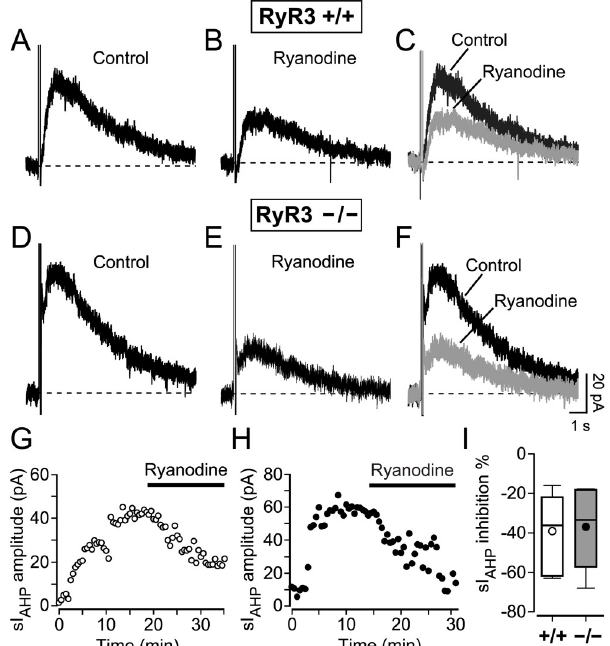
Fig 5. Inhibition of CICR by ryanodine reduced the sI AHP amplitude at steady state in RyR3 +/+ and RyR3 − / − mouse CA1 pyramidal neurons. Representative sI AHP traces obtained from RyR3 +/+ ( A ) and RyR3 − / − ( D ) mouse CA1 pyramidal neurons at steady-state, at the end of the run-up phase. Current traces from the same neurons 15 minutes after the application of 10 μ M ryanodine (RyR3 +/+ ( B ) and RyR3 − / − ( E )). ( C and F) Superimposed traces showing the reduction of the sI AHP amplitude. Scale bars in ( F ) apply to all panels, ( A-F ). ( G ) Time course of sI AHP amplitude in the same RyR3 +/+ neuron as shown in A-C. ( H ) Time course of the sI AHP amplitude in the same RyR3 − / − neuron as shown in D-F. ( I) Overall decrease in the sI AHP amplitude summarized in a box-and-whiskers plot, showing comparable reduction by ryanodine in RyR3 +/+ (mean ± SEM: 39.0 ± 6.9%; median = 36.2%, n = 7) and RyR3 − / − neurons (mean ± SEM: 36.9 ± 9.4%; median = 33.4%, n = 5) (P =